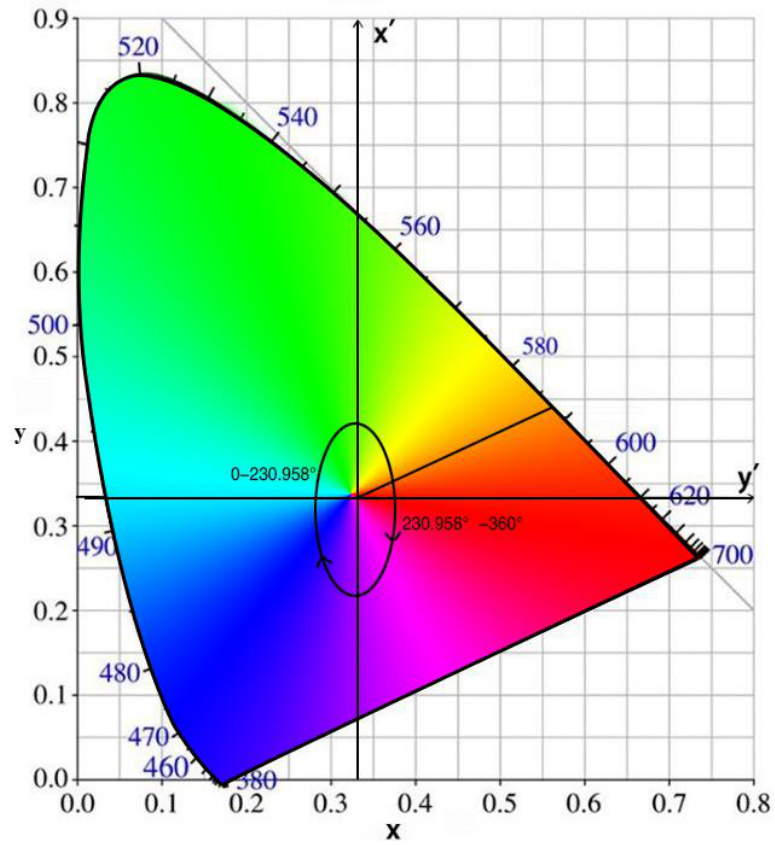
Figure 5. The International Commission on Communication (CIE)-xy chromaticity diagram and two kinds of water bodies. Hue angle α is the angle between the vector to a point and the negative x’-axis (at y = 1 /